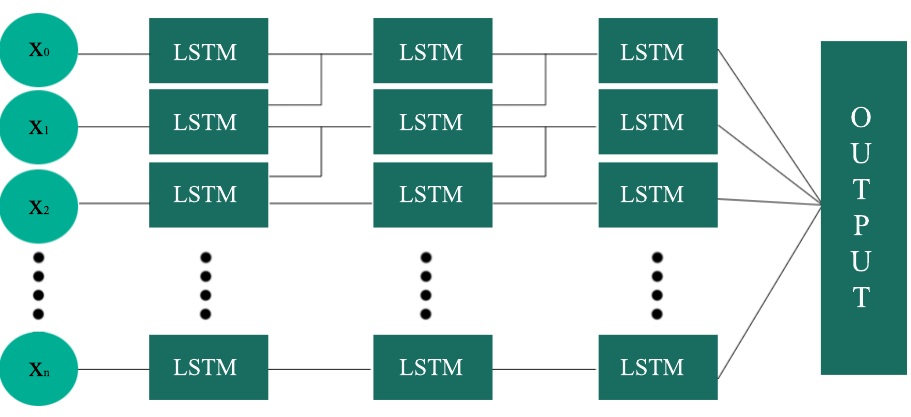
Figure 9. LSTM Recurrent Neural Network